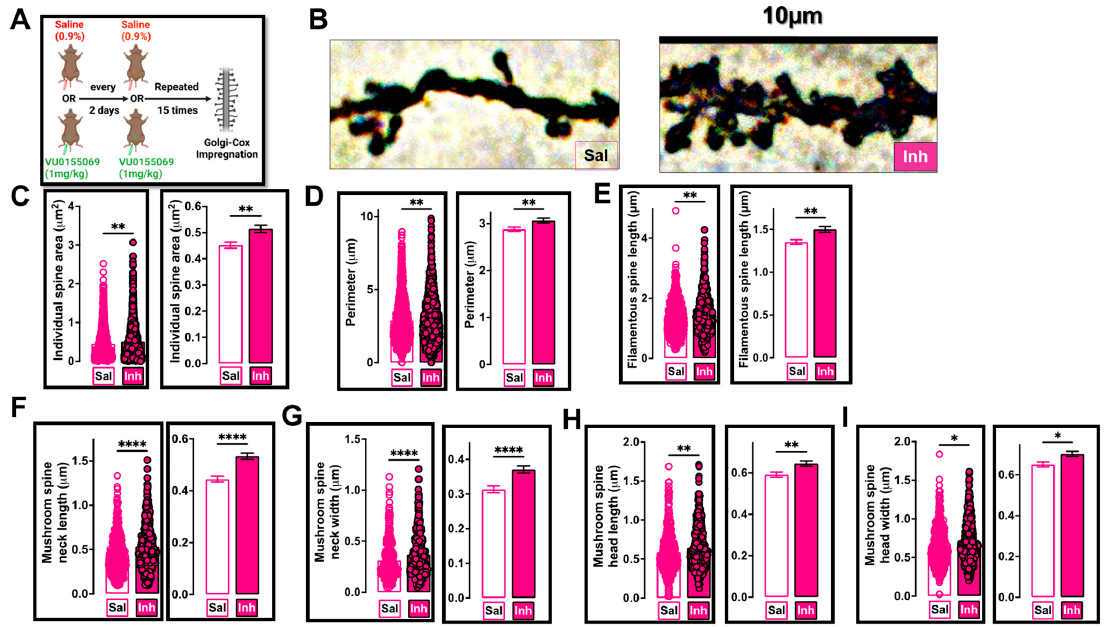
Figure 4. PLD1 inhibition in 12-month-old 3xTg-AD mice prevents progressive A β and tau-driven synaptotoxicity by preserving specific dendritic spine characteristics. ( A ) A separate cohort of 3xTg- AD female mice were injected using the schematic described and the brains removed immediately after the last injection and processed for Golgi–Cox impregnation as described in the methods section. ( B ) Representative dendrites from saline- and inhibitor-treated groups. The panel width corresponds to 10 µ m. ( C ) The individual spine area ( µ m 2 ) was significantly increased in the inhibitor- treated cohort compared to the saline-treated group (** p = 0.0048). ( D ) The perimeter of the selected dendrites was significantly greater in the inhibitor-treated cohort compared to the saline-treated group (** p = 0.0061). ( E ) The length of filamentous or thin spines per 10 µ m was significantly greater in the inhibitor-treated cohort compared to the saline-treated group (** p = 0.0026). ( F ) Mushroom spine neck length ( µ m) was significantly increased in the inhibitor-treated cohort compared to the saline-treated group (**** p < 0.0001). ( G ) Mushroom spine neck width ( µ m) was significantly increased in the inhibitor-treated cohort compared to the saline-treated group (**** p < 0.0001). ( H ) Mushroom spine head length ( µ m) was significantly increased in the inhibitor-treated cohort compared to the saline- treated group (** p = 0.0074). ( I ) Mushroom spine head width ( µ m) was significantly increased in the inhibitor-treated cohort compared to the saline-treated group (* p = 0.0101). Each circle represents an individual spine. Saline circles have colored borders while inhibitor circles have black outline filled with color. For each animal, there were three slices assessed and for each slice there were five representative dendrites that were measured. Each panel has two graphs showing the same comparisons, the left shows the individual values in circles while the right shows the bar graph with the error bars. Values are expressed as mean ± SEM. n = 5 subjects per group (all females, 3 slices per animal and 5 representative dendrites per slice). Unpaired non-parametric Mann–Whitney